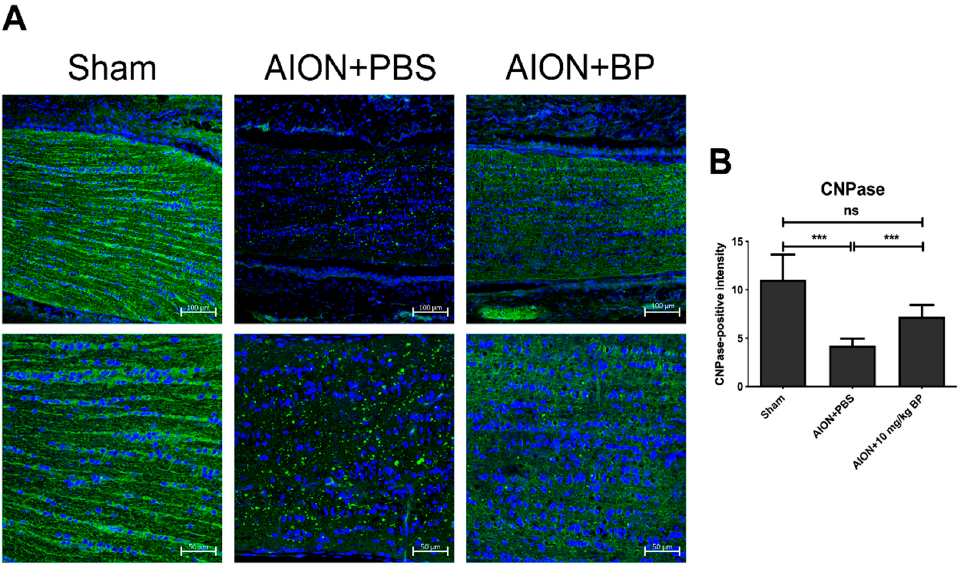
Figure 7. Expression of CNPase in optic nerve. Optic nerve sections reveal the intensity of CNPase in each group. The upper rows represent 10× magnification and the lower rows represent high (20×) magnification in the same specimen. ( A ). The results of quantitative analysis of CNPase+ intensity (green)/DAPI in the sham, PBS-treated, and BP-treated groups were 11.06 ± 2.60, 4.24 ± 0.71, and 7.20 ± 1.22, respectively ( B ). (***, p ≤ 0.001; n.s., not significant; n = 6. The upper column of scale bar = 100 μ m, the lower column of scale bar = 50 μ m).